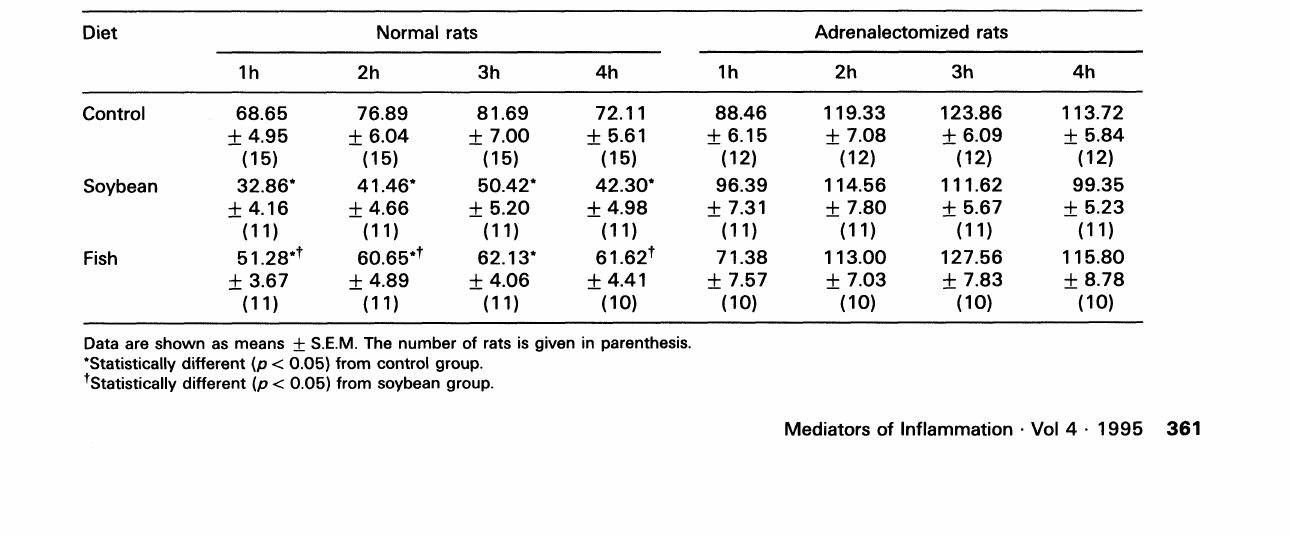
Table 3. Oedema formation (% increase of paw volume) in rat paws 1-4h after carrageenin, in normal and adrenalectomized rats fed the three diets Diet Normal